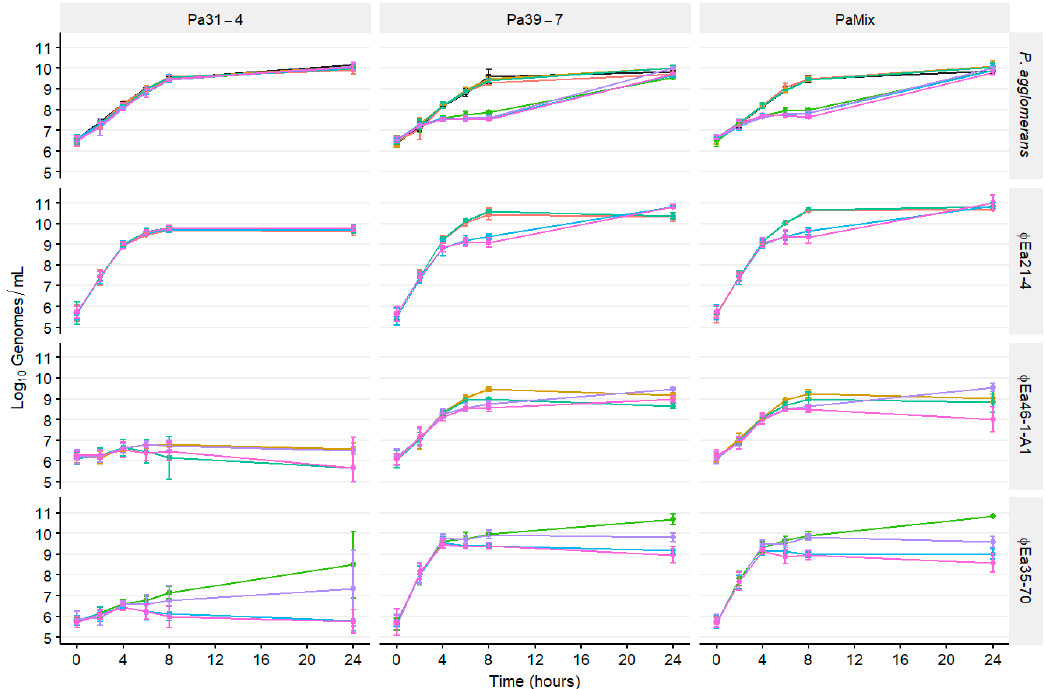
Figure 4. Populations over time of P. agglomerans cultures infected with different phage combinations. The infected strains Pa31-4, Pa39-7, and an equal combination of both (PaMix) are indicated in the top banners. The banners on the right indicate the host or phage quantified. Each host was infected by all possible phage combinations, which are indicated by color: ϕ Ea21-4 ( ● ), ϕ Ea46-1-A1 ( ● ), ϕ Ea35-70 ( ● ), ϕ Ea21-4 + ϕ Ea46-1-A1 ( ● ), ϕ Ea21-4 + ϕ Ea35-70 ( ● ), ϕ Ea46-1-A1 + ϕ Ea35-70 ( ● ), ϕ Ea21-4 + ϕ Ea46- 1-A1 + ϕ Ea35-70 ( ● ), no phage ( ● ). Genomic titers of P. agglomerans and each phage were determined with qPCR. Data are the mean ± SD of three replicates.